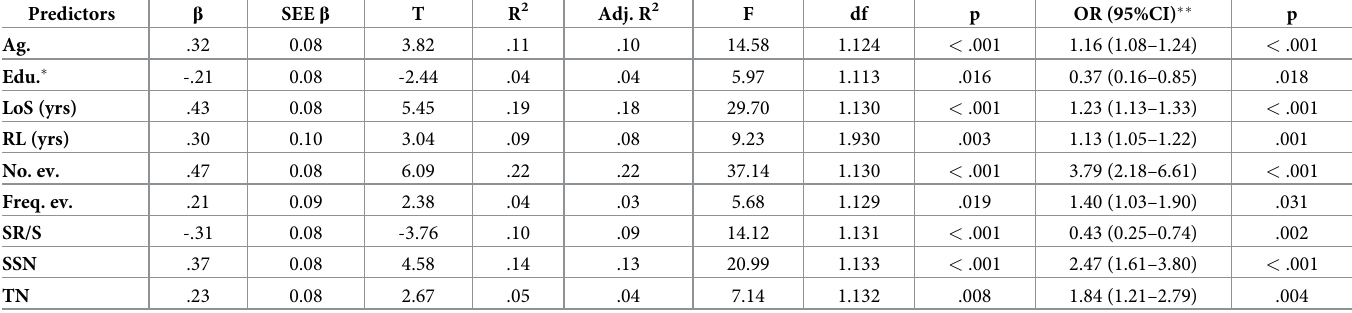
Table 6. Results of the series of univariate regressions with the IES-R total score as a dependent variable and the series of logistic regressions with probable PTSD and no PTSD as a dependent variable and male role norms, social relations/ support, and sociodemographic and trauma-related data as independent predictors in both cases. Predictors